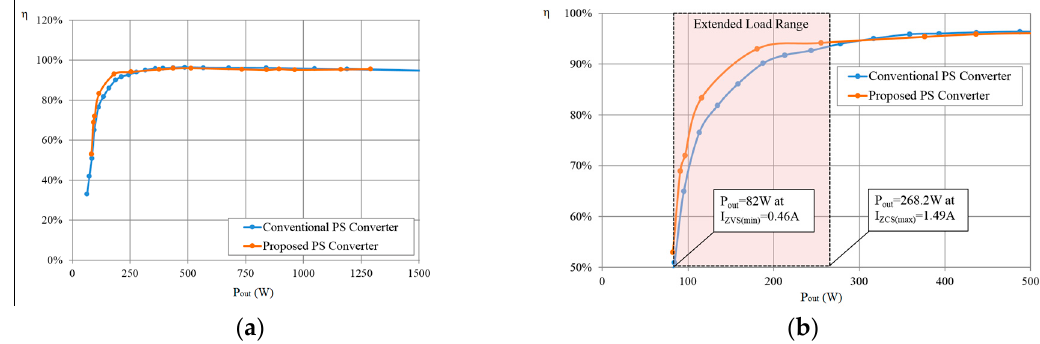
Figure 9. Efficiency and Load Range: ( a ) Conversion Efficiency of Full Load Range; ( b ) Conversion Efficiency of Light Load Range.